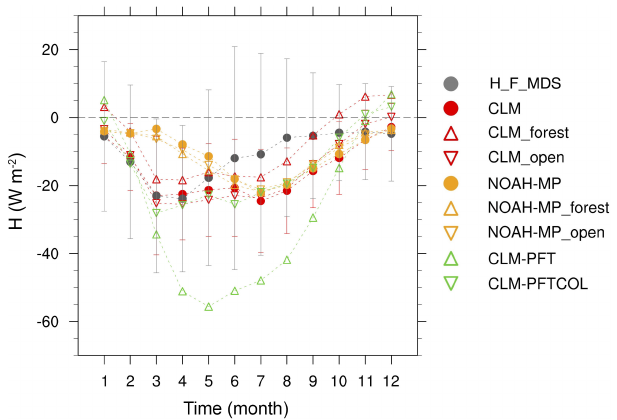
Figure 6. Change in the seasonal cycle of H (Wm − 2 ) due to LULCC from forest to open land (open −